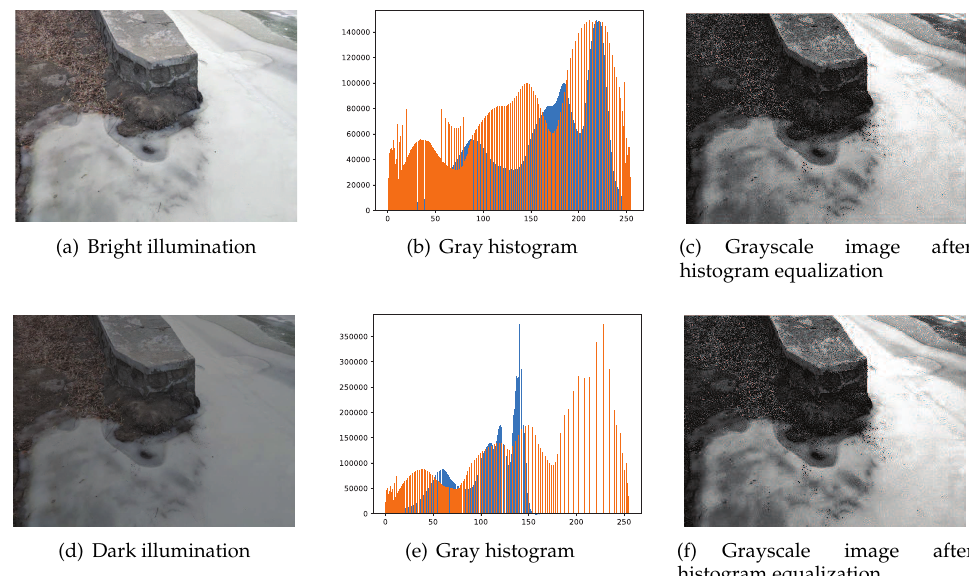
Figure 10. Histogram equalization reduces the sensitivity to the changes of the overall environment illumination. The illumination of ( d ) is much darker than that of ( a ), but histogram equalization greatly reduces the illumination difference between the two images. ( c , f ) are the processed image. In ( b , e ), the blue bars represent the original gray distribution, and the orange bars represent the processed gray